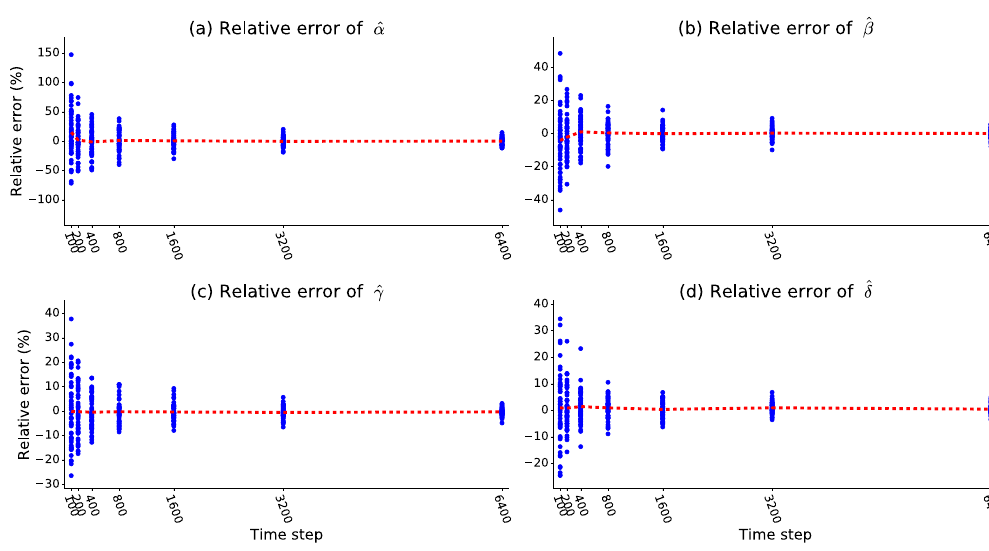
Figure 2. Parameter recovery in the fire-propagation model. The x-axis includes seven time intervals: 100, 200, 400, 800, 1600, 3200 and 6400 time steps. The y axis shows the relative error for the recovered parameters. Using parameter values shown in Table 2, parameter recovery was run on 50 different historical datasets generated by simulations with different seeds for the random number generator; the results of these runs are represented by blue dots. The red dashed curves show the average values of the relative error. The visible trend is that the average of relative errors tends asymptotically to zero and the variance exhibits power law decrease as the number of time steps increases, which means more training data improves the performance of parameter